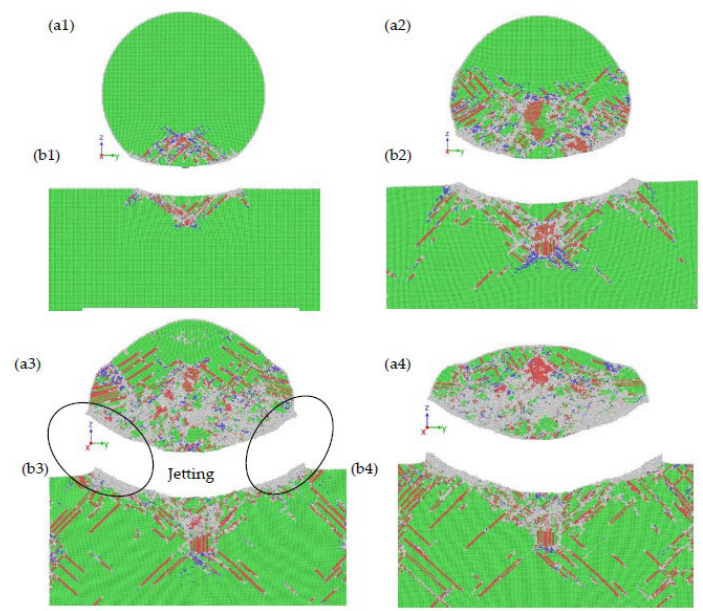
Figure 11. The microstructure snapshots of the Ni particle ( a1 – a4 ) and Cu substrate ( b1 – b4 ) at times of ( a1 , b1 ) 5 ps, ( a2 , b2 ) 10 ps, ( a3 , b3 ) 15 ps, and ( a4 , b4 ) 20 ps. (after impact) at 1000 m/s. The local atomic structure: FCC (green), HCP (red), blue (BCC), and grey (atoms without crystalline structure). The circles designated the jet formation at the periphery as the atoms flow upward from the substrate.